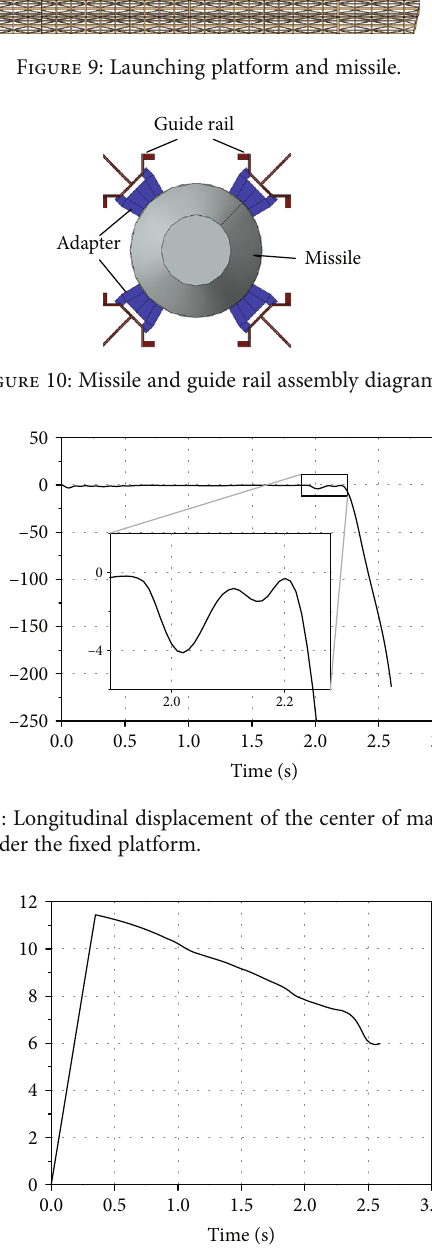
Figure 12: The speed of the missile ’ s centroid under the fi xed